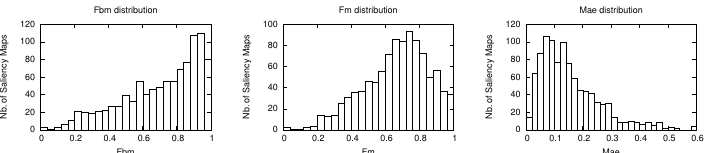
Figure 6. From left to right, distribution of the F β , F and MAE measures given by our UMESM (unsupervised Markovian estimation of saliency map) model on the 1000 images of the ECSSD